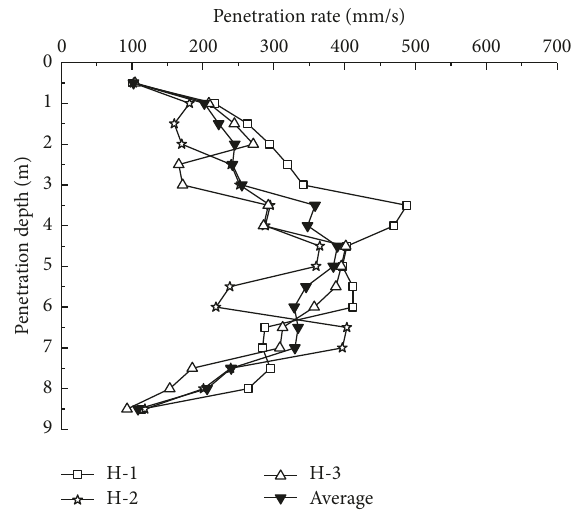
Figure 7: Penetration rate of piles in series H versus penetration